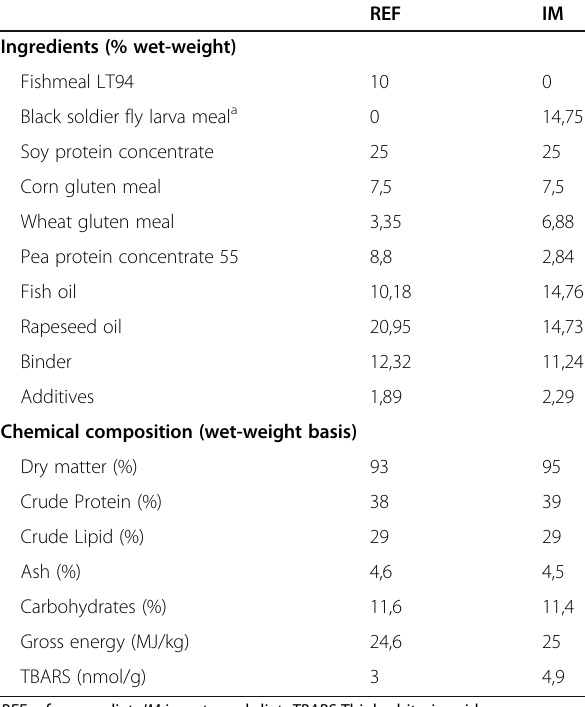
Table 1 Formulation and proximate composition of the experimental